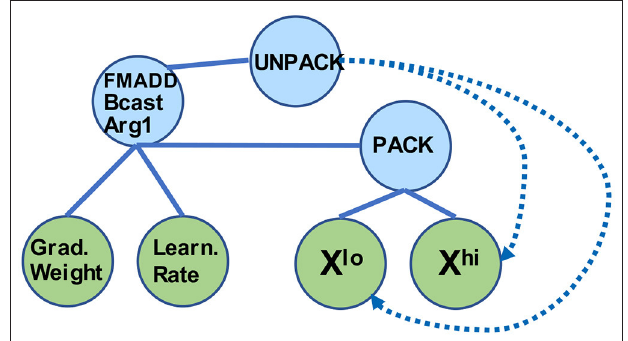
FIGURE 16 | BF16 Split-SGD operator by combining